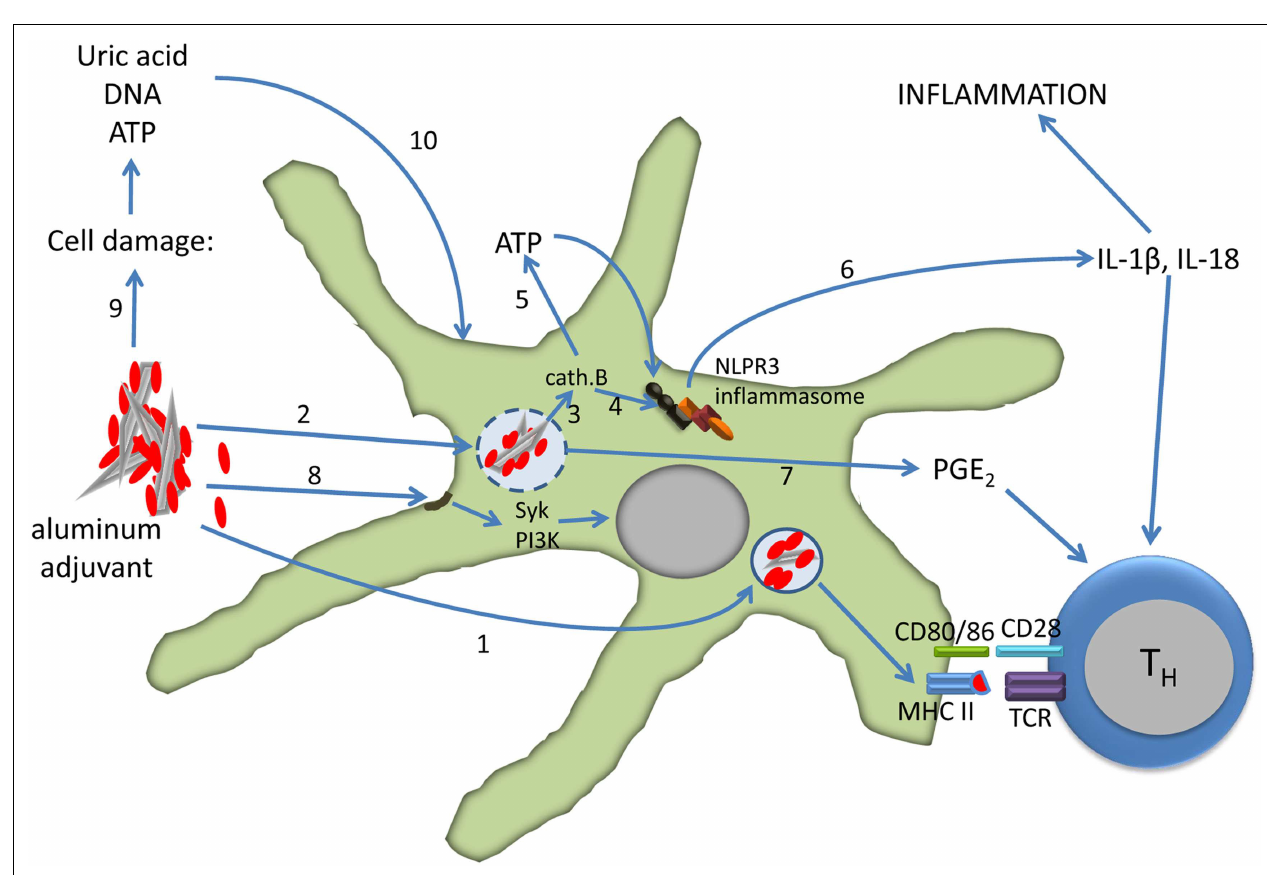
released from the cell (6). Phagolysosome destabilization also induces the secretion of PGE2 (7), and PGE2, IL-1 β , and IL-18 all support the differentiation of CD4T cells intoTh2 cells. Aluminum adjuvants also directly interact with the lipid rafts in the cell membrane which results in activation of the Syk and PI3-kinase signaling pathways (8). Injection of aluminum-adjuvanted vaccines causes cell damage and necrosis with release of uric acid, ATP, and DNA (9).These molecules in turn activate dendritic cells (10). See the text for more details and